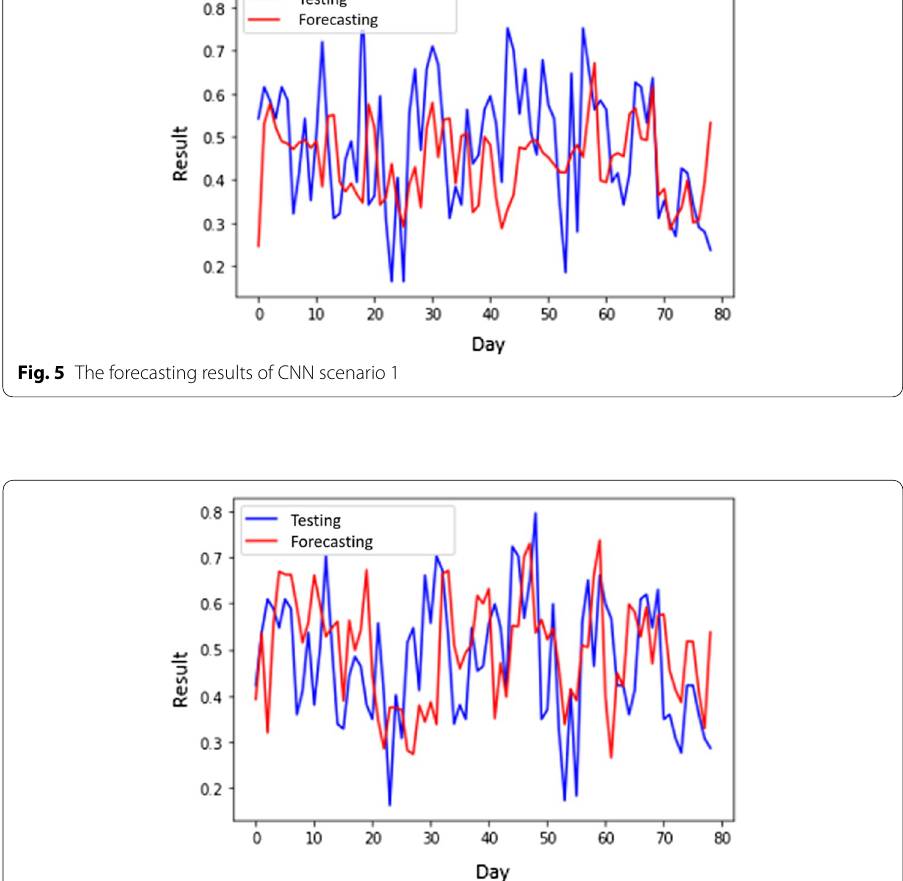
Fig. 6 The forecasting results of S-CNN scenario